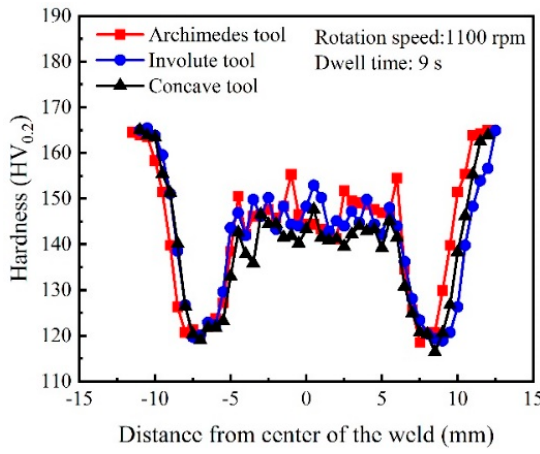
Figure 11. Microhardness measured at the cross sections of the P-FSSW joints.